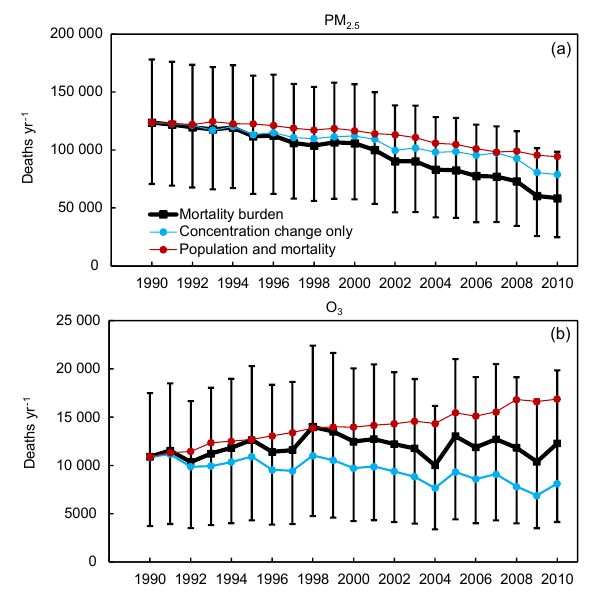
Figure 3. Trends in the total mortality burden (black) for PM 2 . 5 ( a , as a total of ischemic heart disease (IHD) + stroke (STROKE) + chronic obstructive pulmonary disease (COPD) + lung cancer (LC)) and O 3 ( b , chronic respiratory disease (RESP)), and mortality burdens considering the air quality change only (blue), and with air quality changes excluded (red). Units are deathsyear − 1 . The error bars are the 95% CI for the total mortality burden (black).